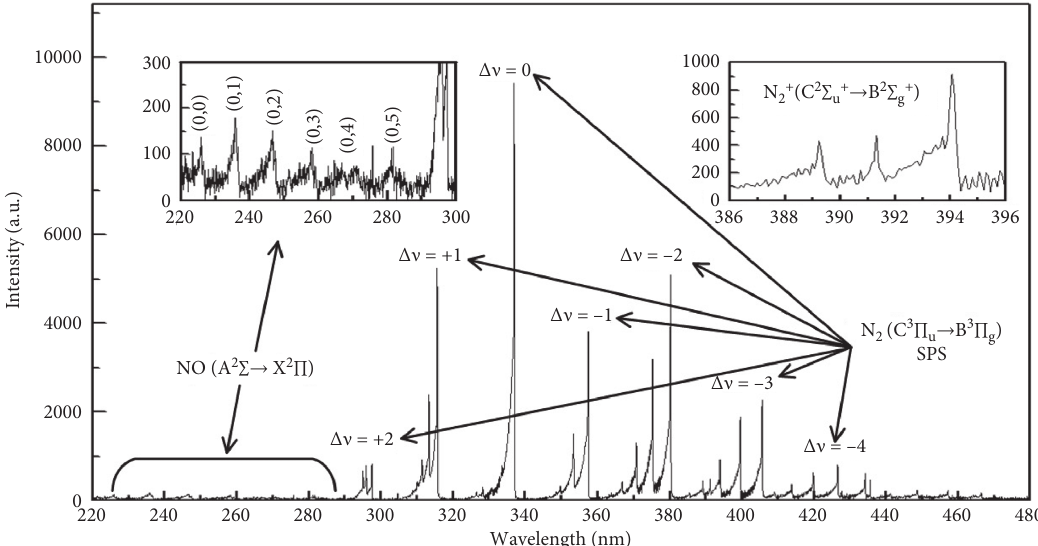
Figure 9: Typical coaxial DBD-PACA spectra at atmospheric pressure.